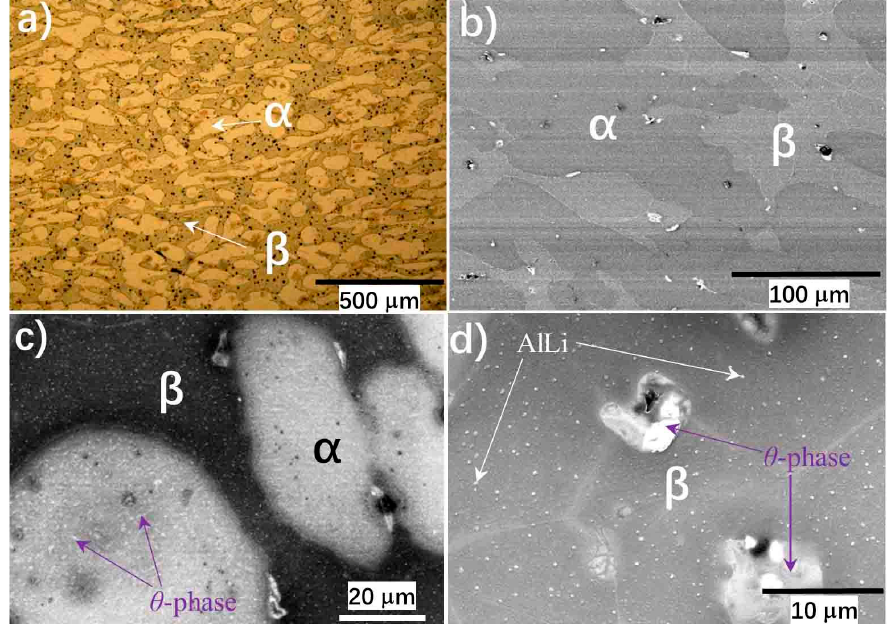
Figure 2. Microstructures of the as-rolled MA21 alloy plates. ( a , b ) show the α + β duplex phase structure observed by OM metallographic and TEM, respectively. ( c , d ) display the fine phase structure observed by back-scattered electrons model of SEM in the α and β phase, respectively.